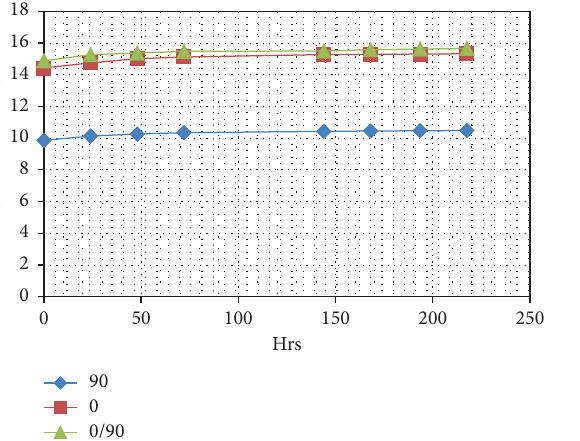
Figure 19: Water